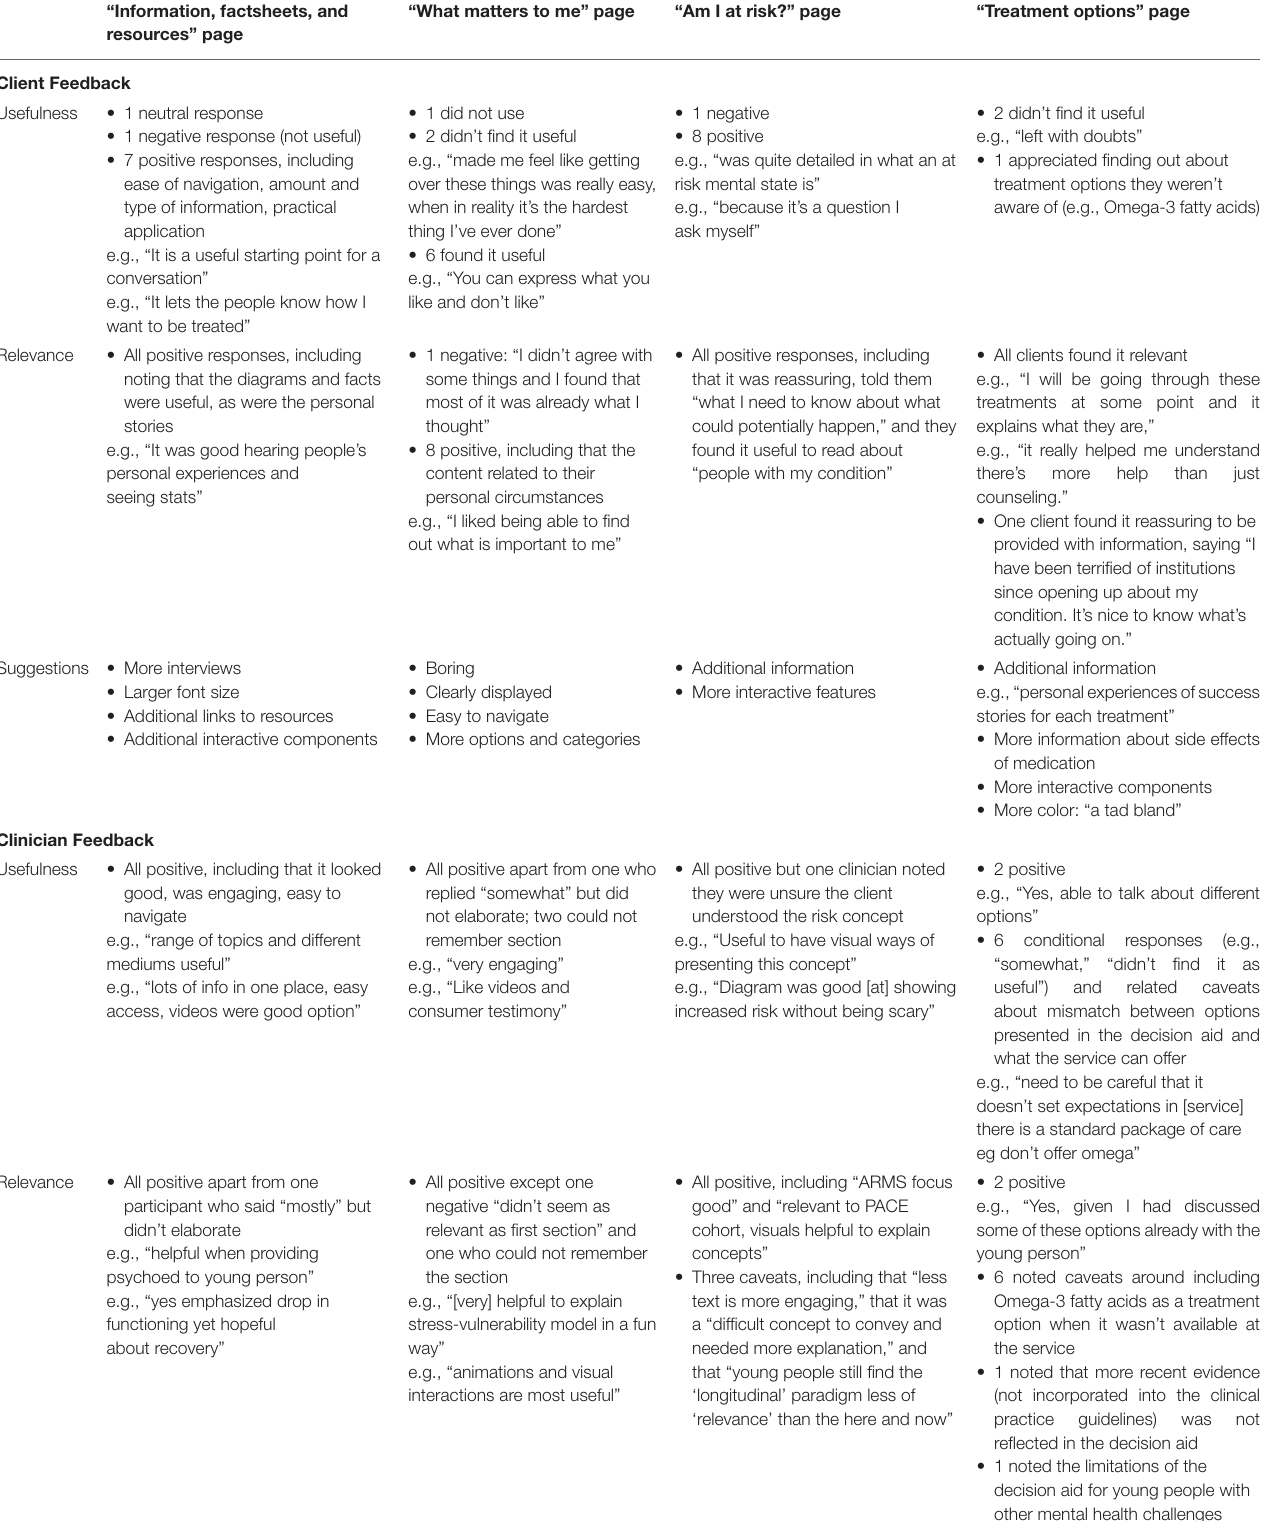
TABLE 1 | Feedback from client and clinician participants on each section of the decision aid. “Information, factsheets, and “What matters to me” resources” page